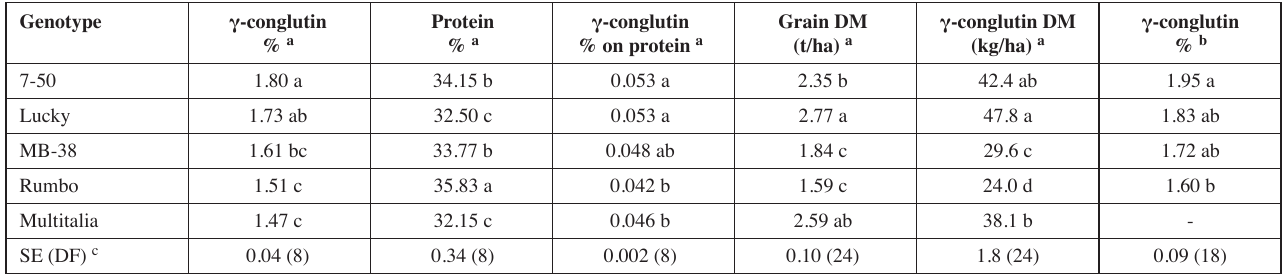
Tab. 2: Mean values over two climatically-contrasting Italian locations of seed γ-conglutin and protein contents (in % w/w) measured by HPLC and Kjeldahl methods, respectively, and grain and γ-conglutin dry matter (DM) yield, for five white lupin genotypes. Genotype